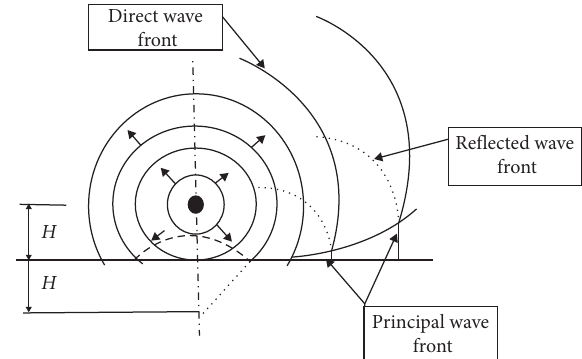
Figure 1: Schematic representation of the progressive position of wave fronts due to an explosive event